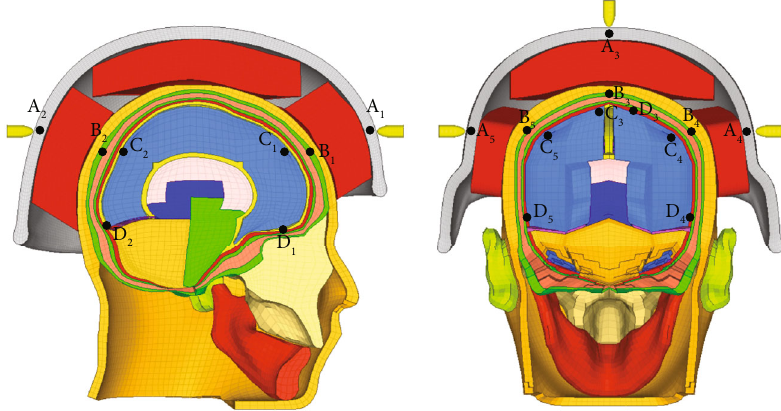
Figure 7: Measurement location of di ff erent impact points.